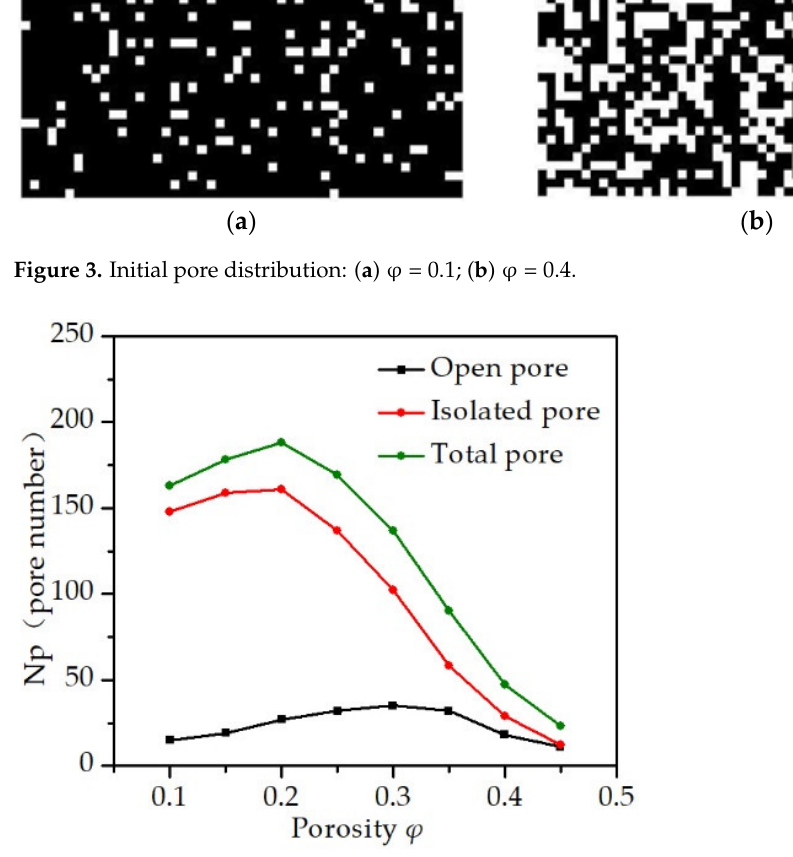
Figure 4. Pore number changing as φ increases.